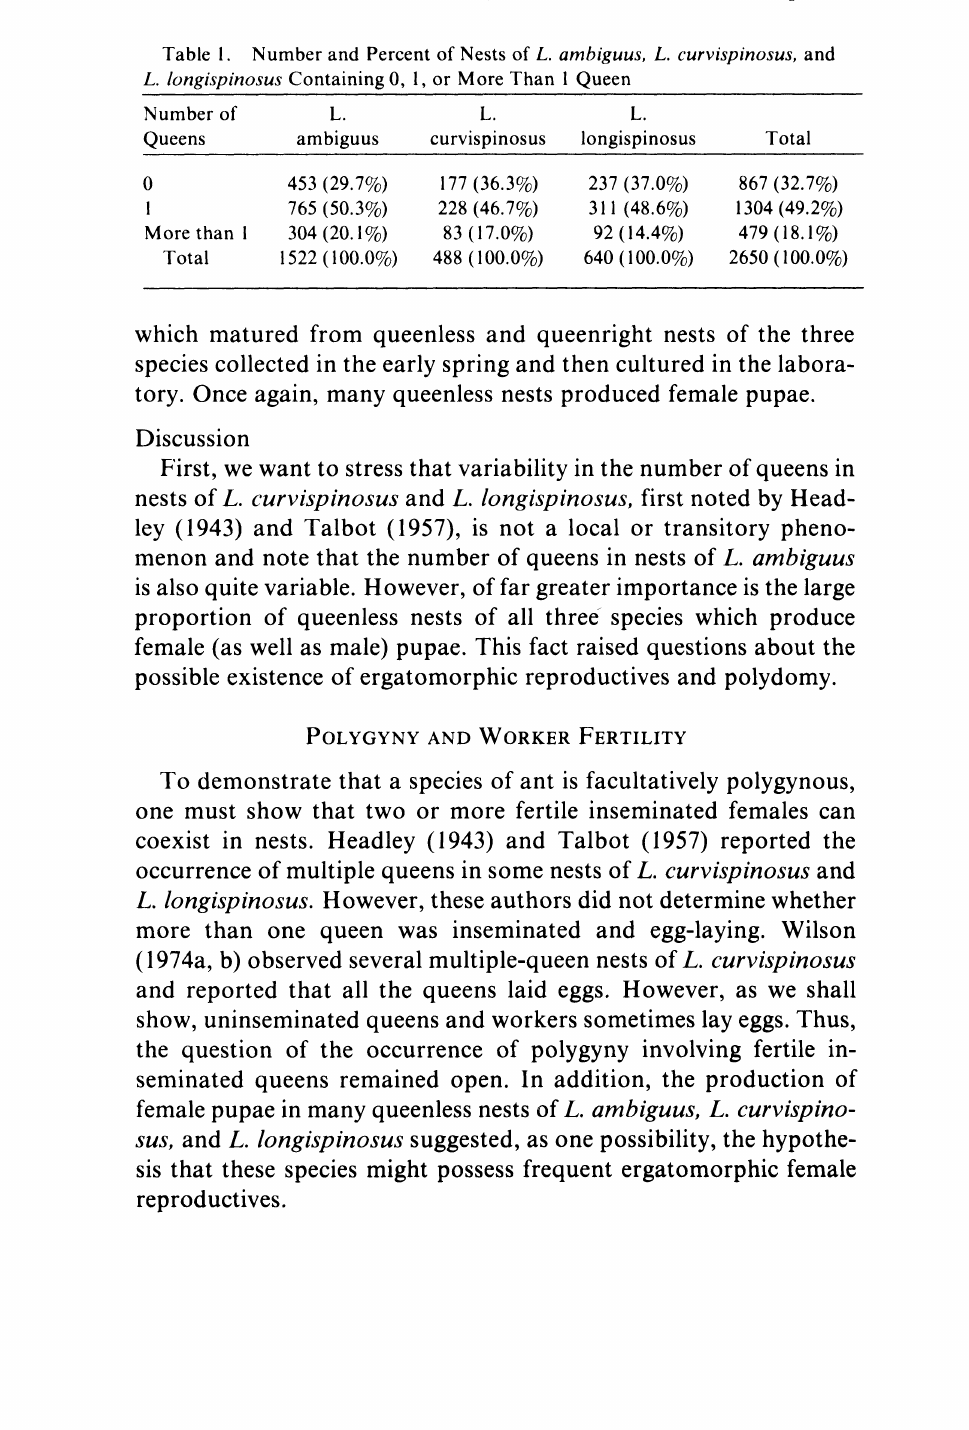
Table 1. Number and Percent of Nests of L. ambiguus, L. curvispinosus, and L. longispinosus Containing 0, 1, or More Than Queen Number of L. L.